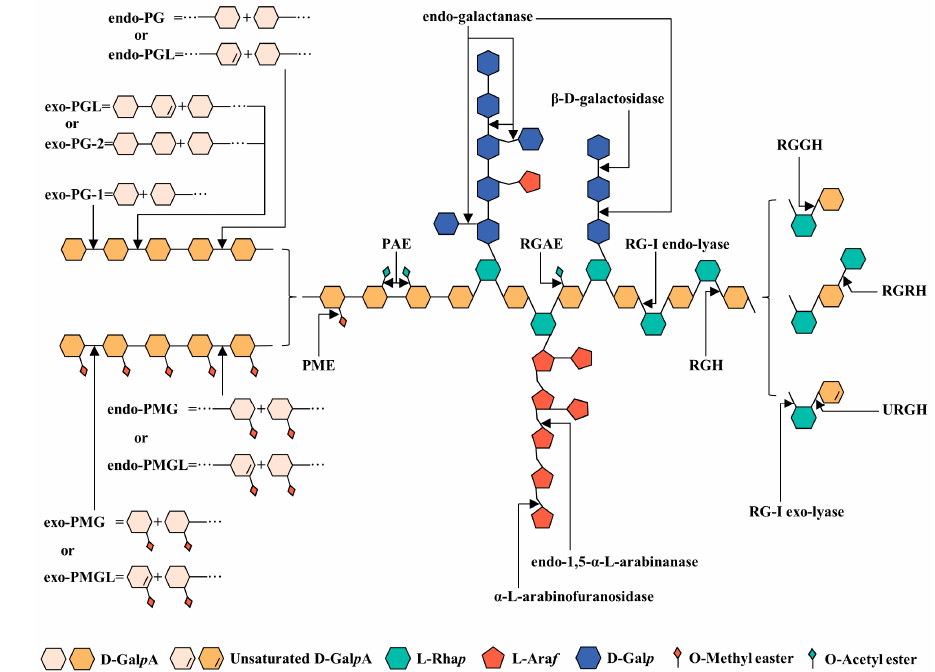
Figure 2. A summary of the action modes of enzymes used to modify pectin. Table 2. Enzymes used in enzymatic modification.